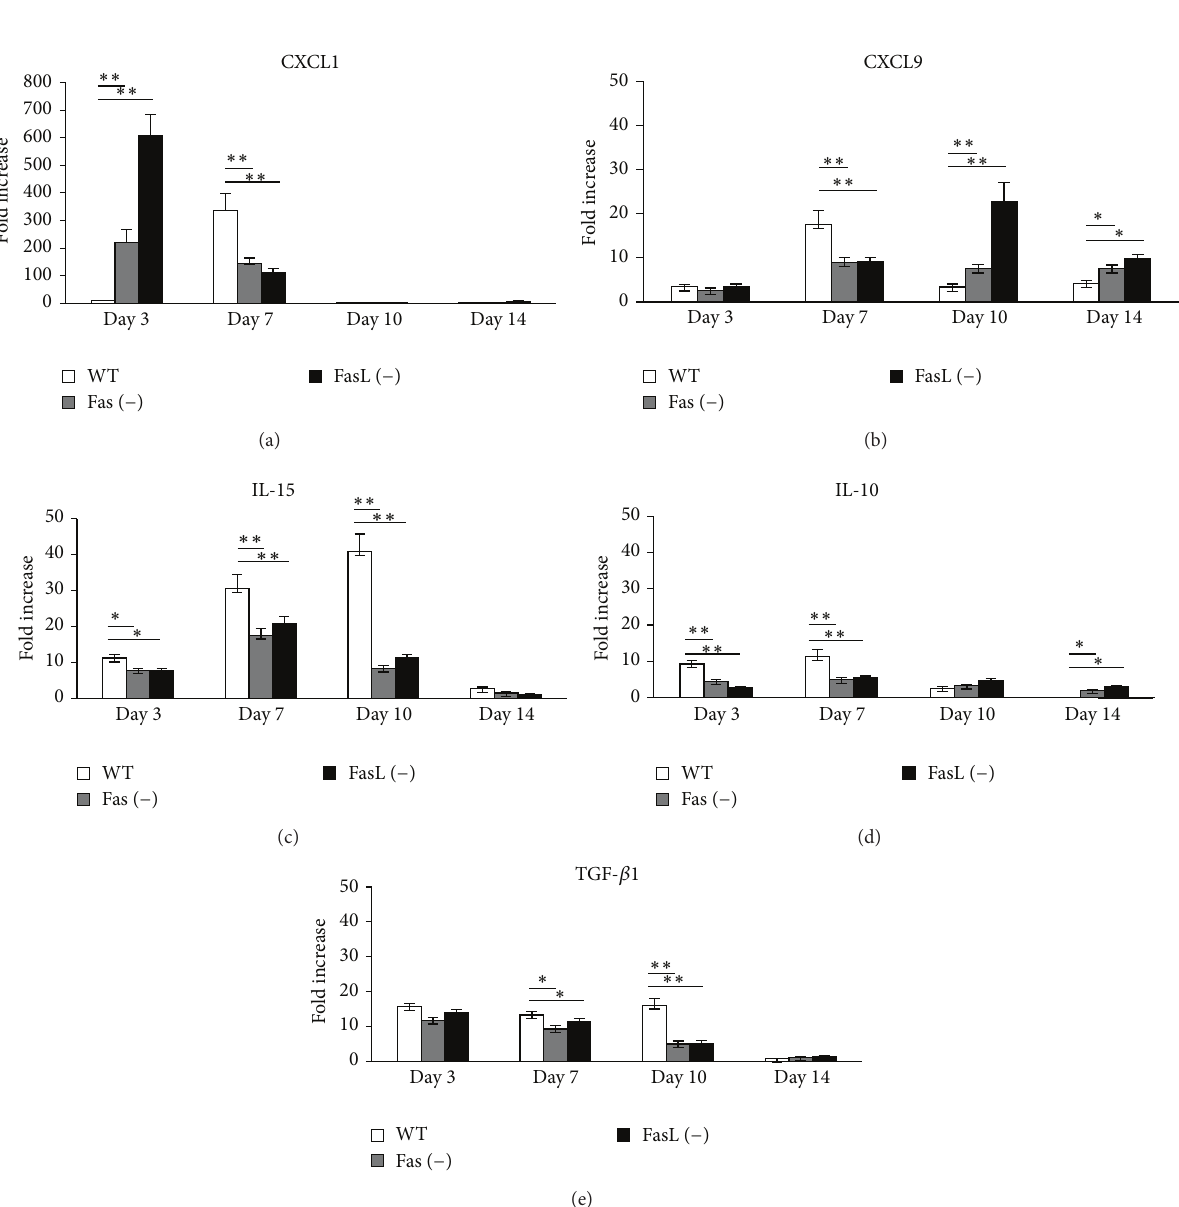
Figure 4: Lack of Fas or FasL during mousepox infection results in disturbances of cytokine and chemokine production. Relative mRNA levels of CXCL1, CXCL9, IL-10, IL-15, and TGF- 𝛽 1 in the lungs isolated from Fas ( − ), FasL ( − ), and WT (C57BL/6) mice at 3, 7, 10, and 14 days of ECTV infection and from control, uninfected mice. The mRNA expressions were normalized by that of GAPDH, and the lungs of control, uninfected mice were estimated as 1. The bars represent the mean from 3 separate experiments ± SEM. ∗ Significant differences with 𝑃 ≤ 0.05 and ∗∗ 𝑃 ≤ 0.01